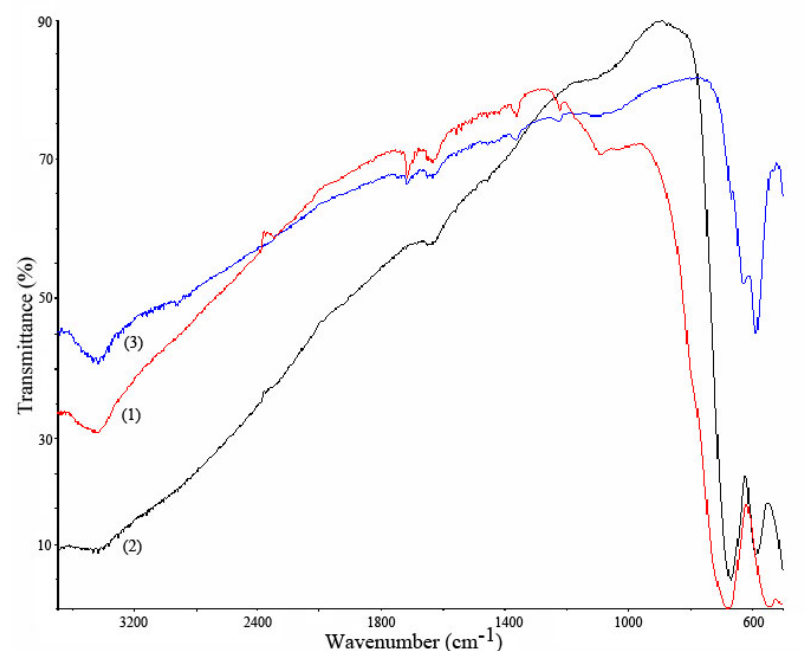
Figure 7. Infrared spectra of CoAl